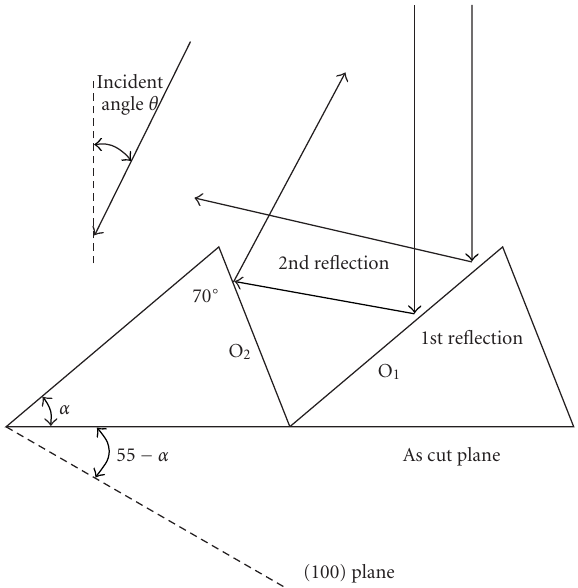
Figure 3: Schematic illustration of reflection on the surface of mc- silicon after alkaline etching.